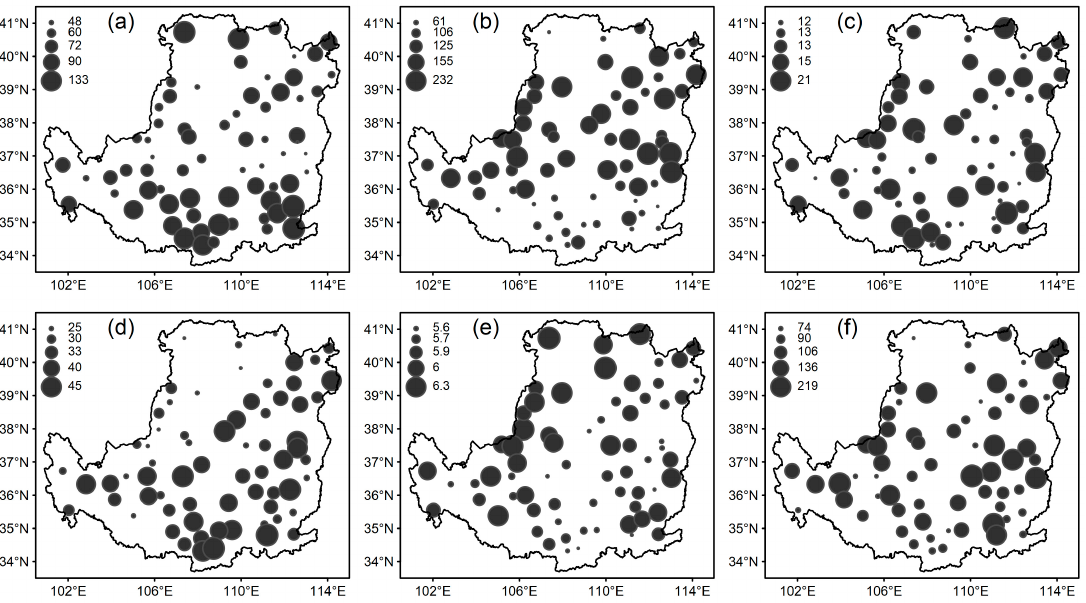
Figure 6. The joint returns periods of each combination group under the condition of 10-year return periods of two single indicators. ( a – e ) Represent six combinations of events: {PRTOT_L, CDD_R}, {PRTOT_R, CDD_R}, {D95_R, P95_R}, {P95_R, I95_R}, {P95_R or I95_R}, and {P95_R, CDD_R}.